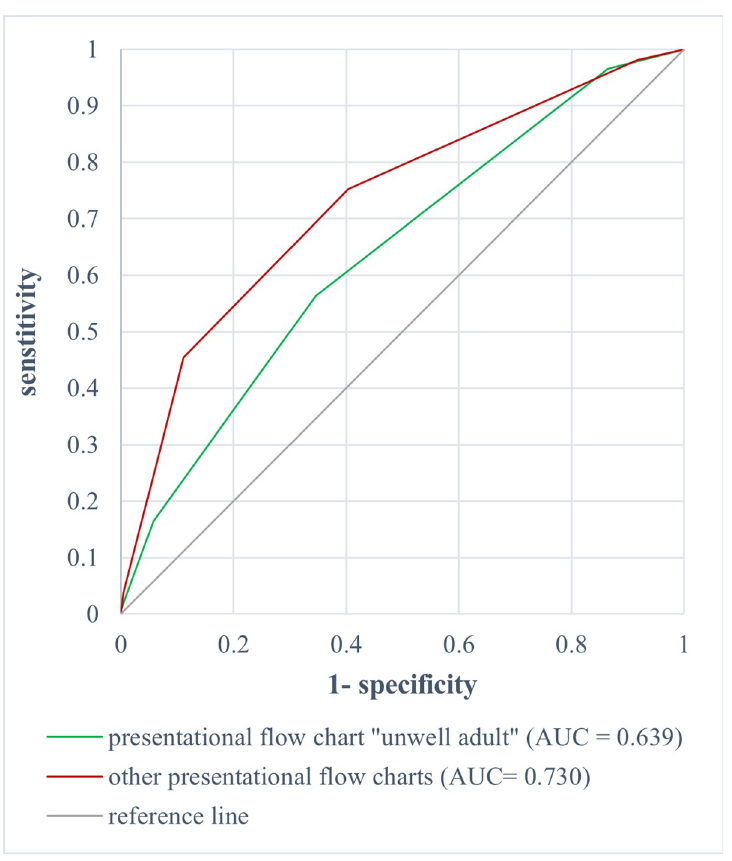
Fig 5. ROC analysis of MTS level and admission to hospital in general of patients aged � 65 years for the presentational flow chart “unwell adult” (AUC = 0.639 [0.578–0.701]) vs. the other flow charts (AUC = 0.730